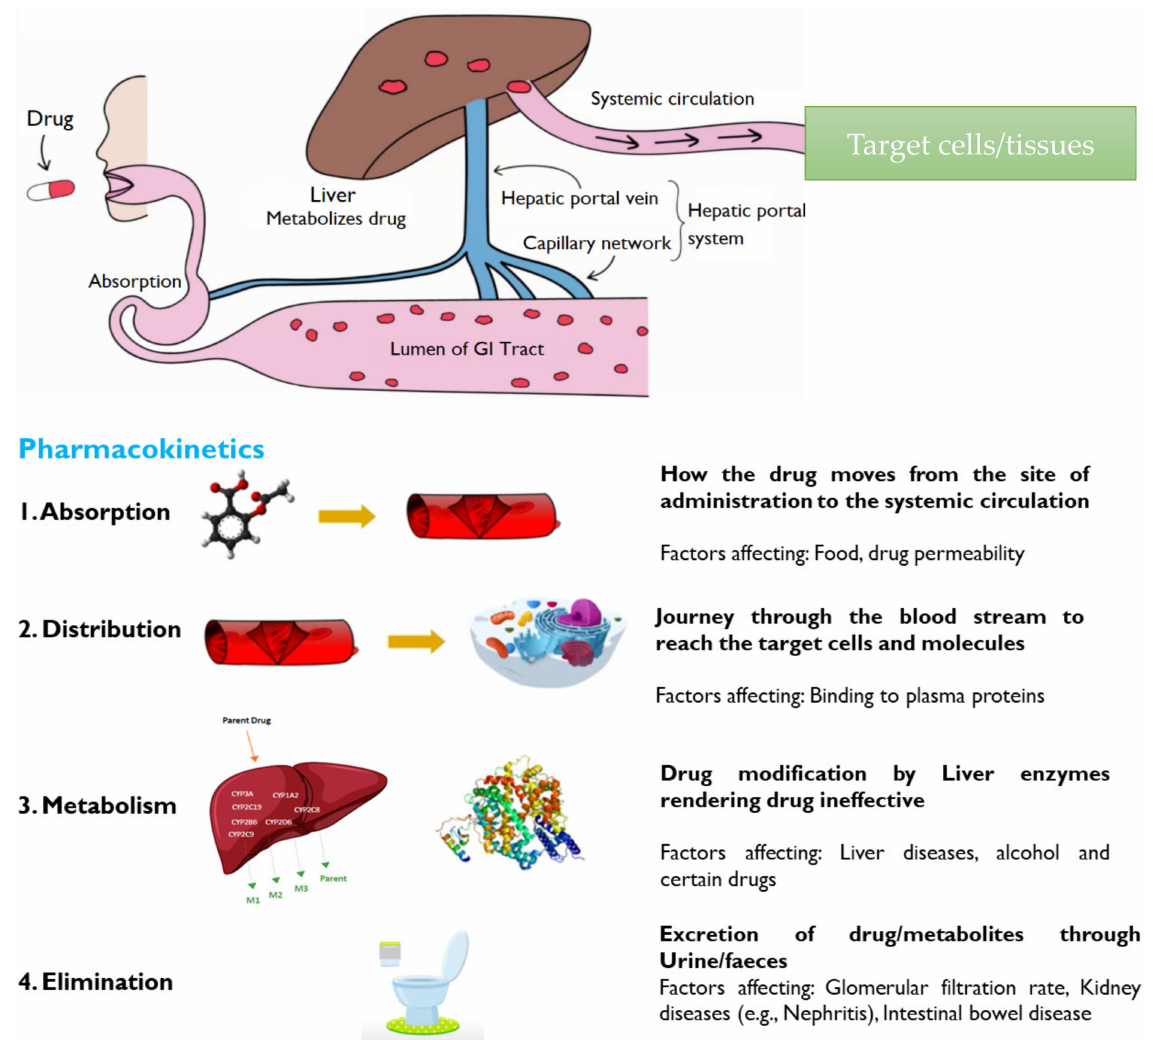
Figure 10. Pharmacokinetic phases of a drug: 1. Absorption, 2. Distribution, 3. Metabolism, 4.